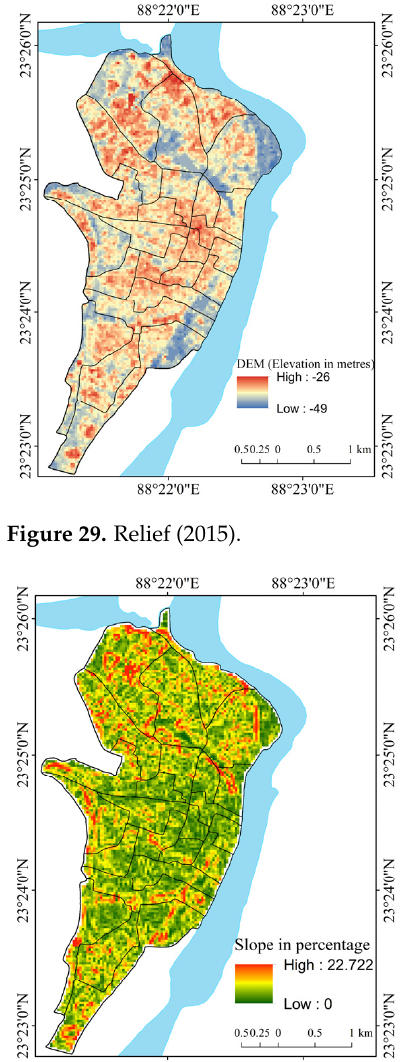
Figure 28. NDFI2 (2000).